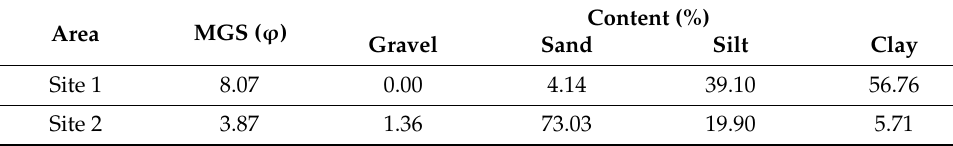
Figure 3. Ternary diagrams of sand-silt-clay; ( a ) Site 1, ( b ) Site 2.